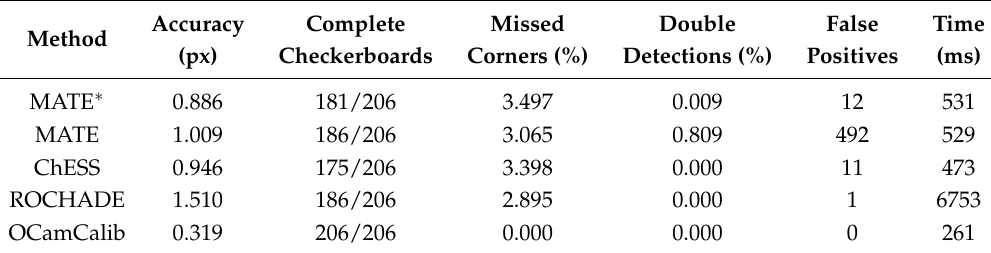
Table 3. Results on the uEye dataset from [14].